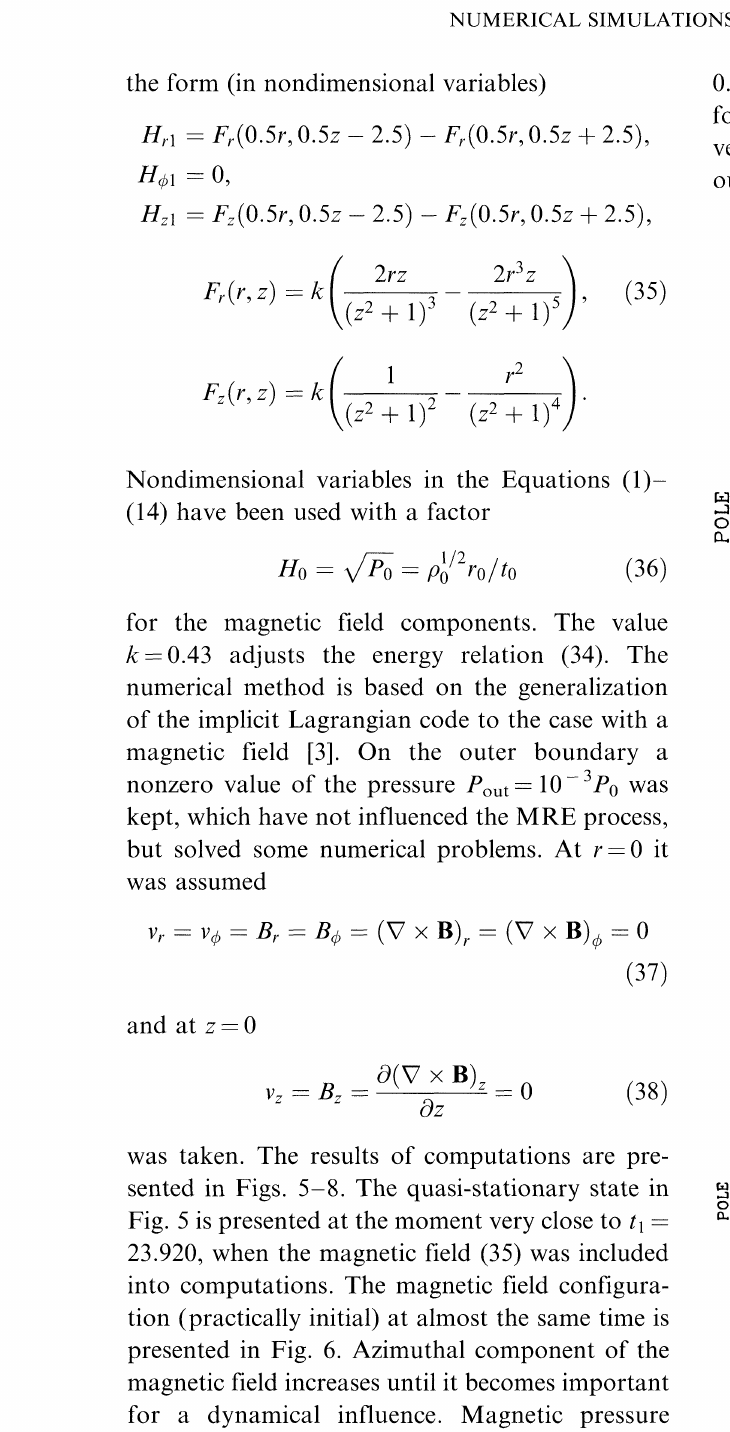
FIGURE 5 Triangular grid at t=23.929313, from [3].